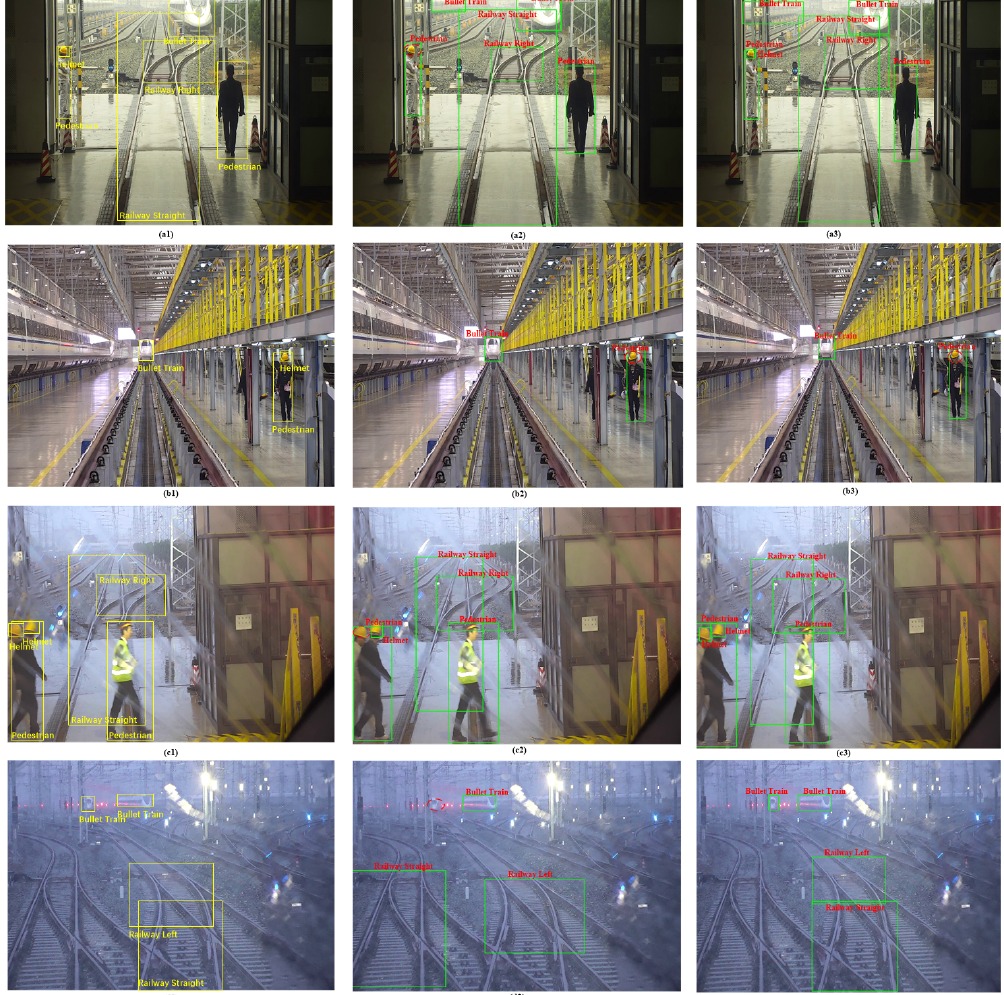
Figure 8. FR-Net vs. SSD300. All three models were trained with the railway dataset that was mentioned above. The left column represents the original detection images and the yellow rectangles denote the ground truth of the objects. The middle column contains the results from the conventional SSD300, and the right column is from the proposed method. The first row denotes scenario of object detection of outside train garage, the second row denotes object detection in repair scence of train garage, the third row represents pedestrain detection of train garage, the fourth row denotes object detection during driving train. Bounding boxes with a score of 0.8 or higher are drawn. The red dotted line represents the category that was not detected.